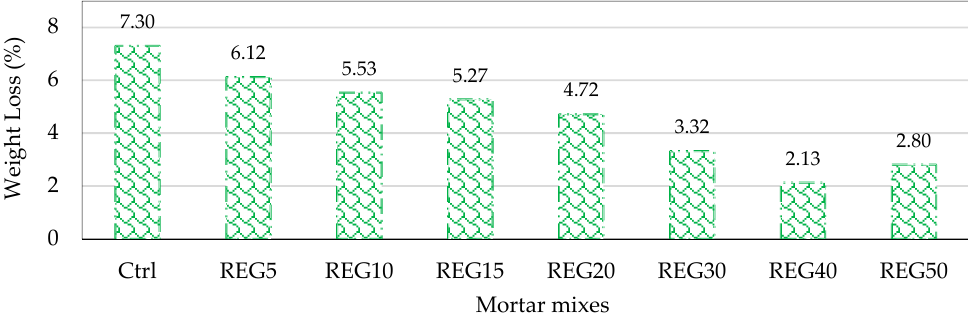
Figure 19. Weight loss percentage of all specimens after 7 days’ immersion in 25% sulphuric acid solution.